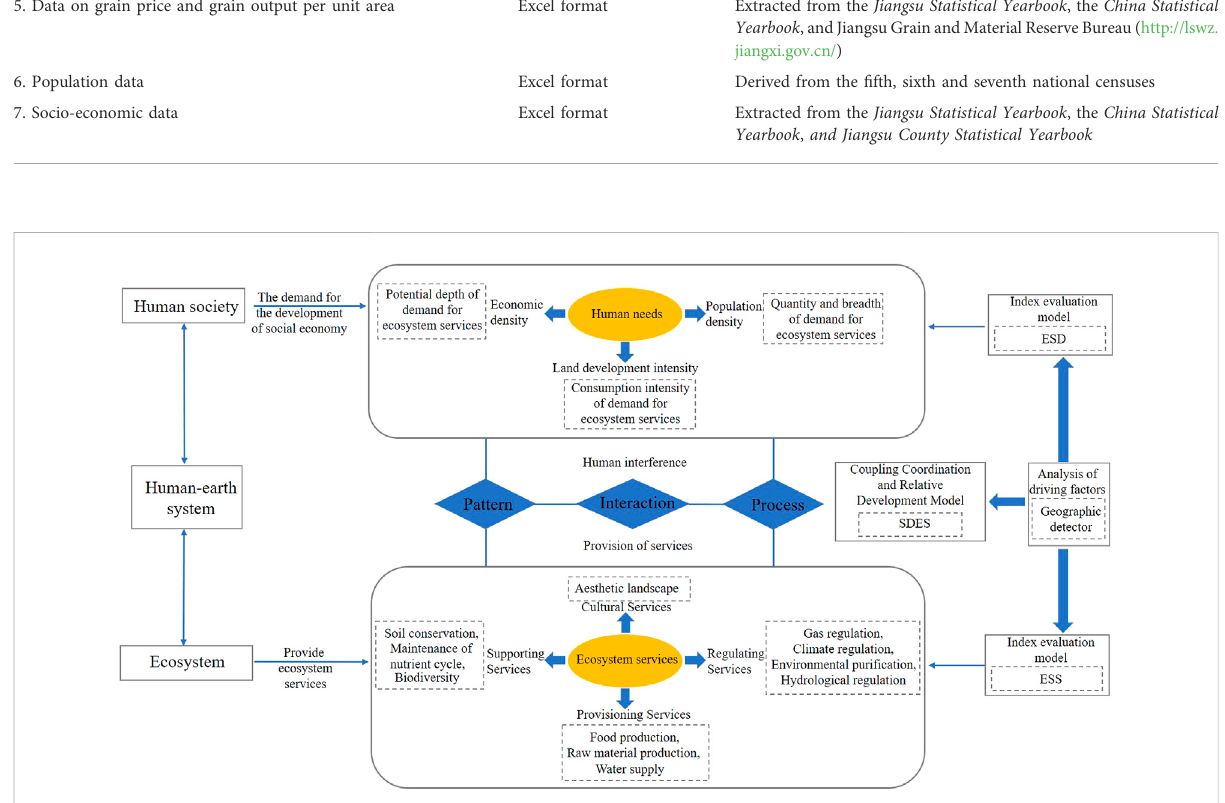
FIGURE 2 The analytical framework of this